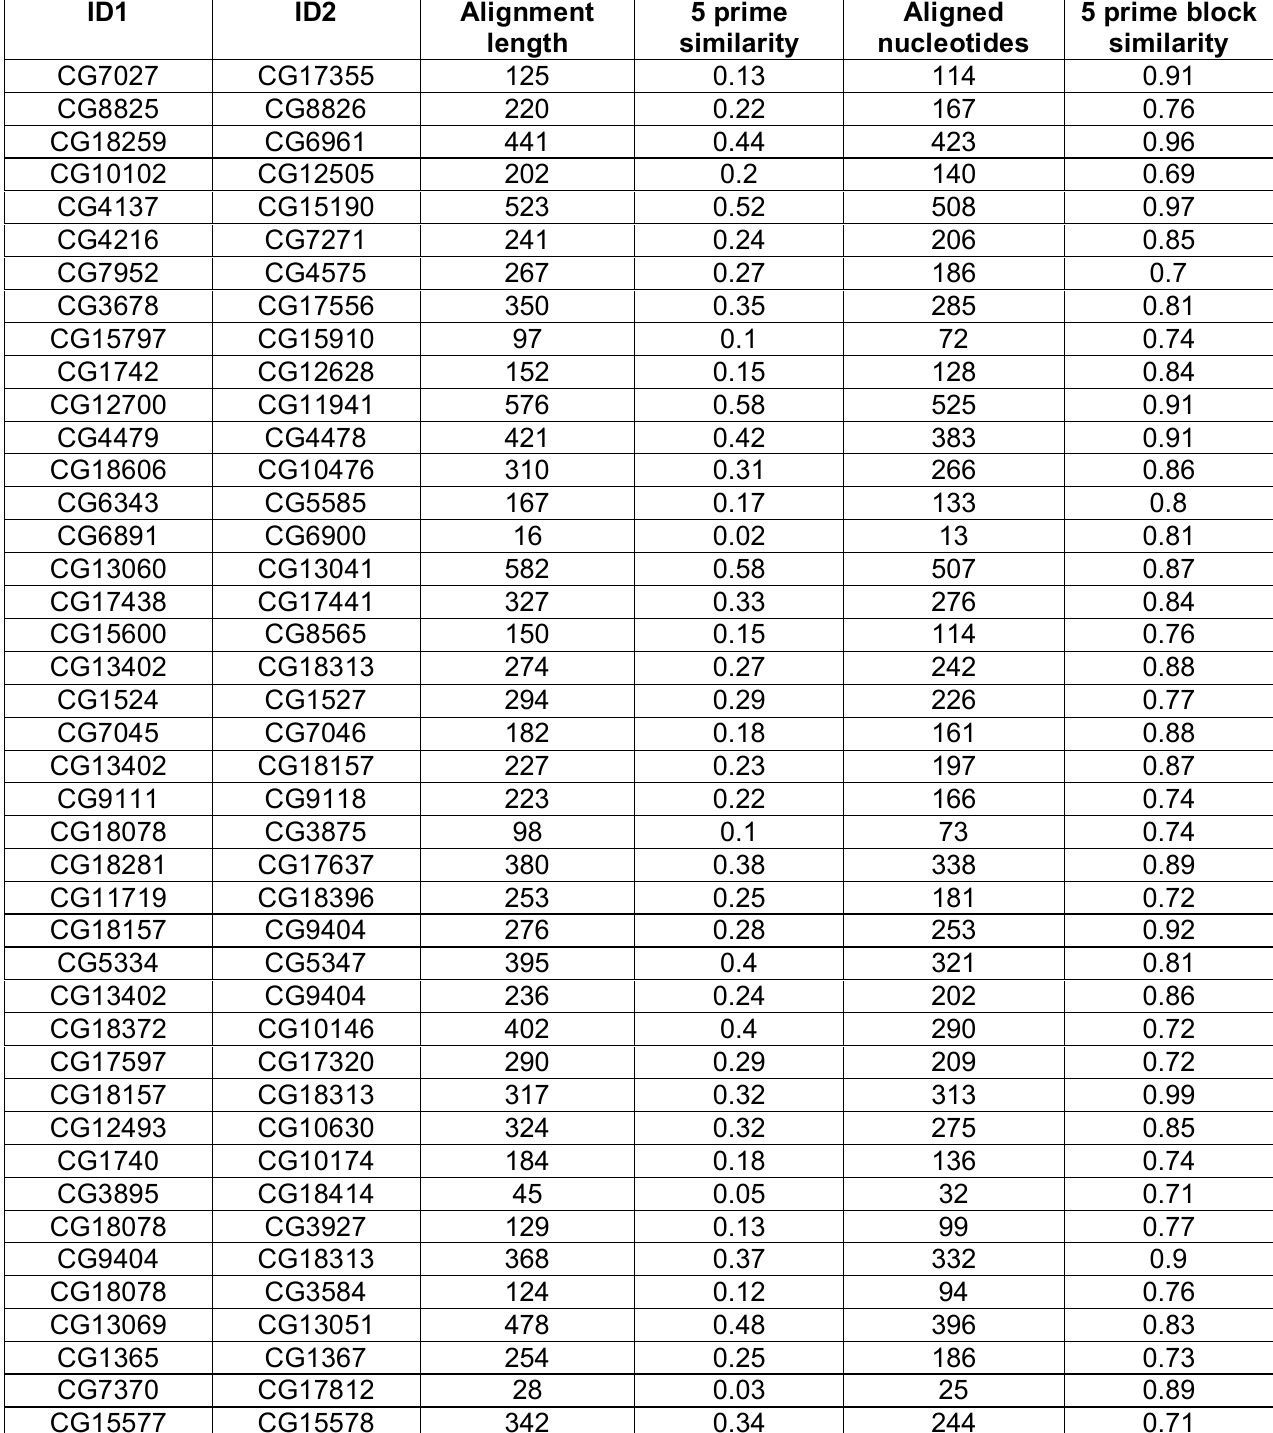
Table S1. Listing of 418 gene duplicate pairs for which alignments of their 5 prime regions were analyzed. Given are, from left to right, Gene IDs #1 and 2, the length of the alignment in base pairs (bp), 5 prime similarity, the number of matched up nucleotides in the aligned segment, and resulting 5 prime block similarity (see